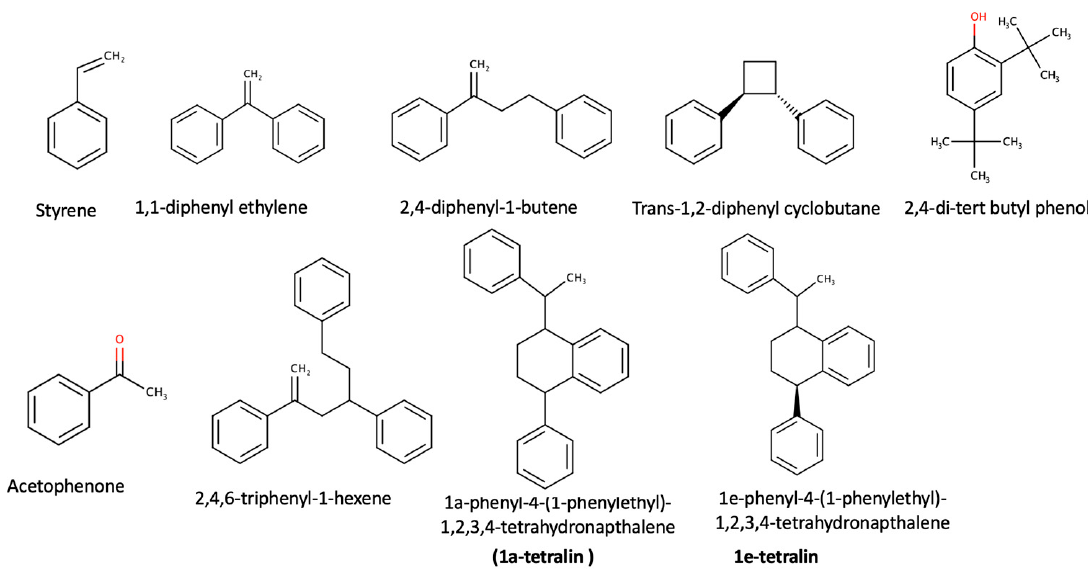
Figure 1. Chemical structures of identified monomers and side reaction products (acetophenone).